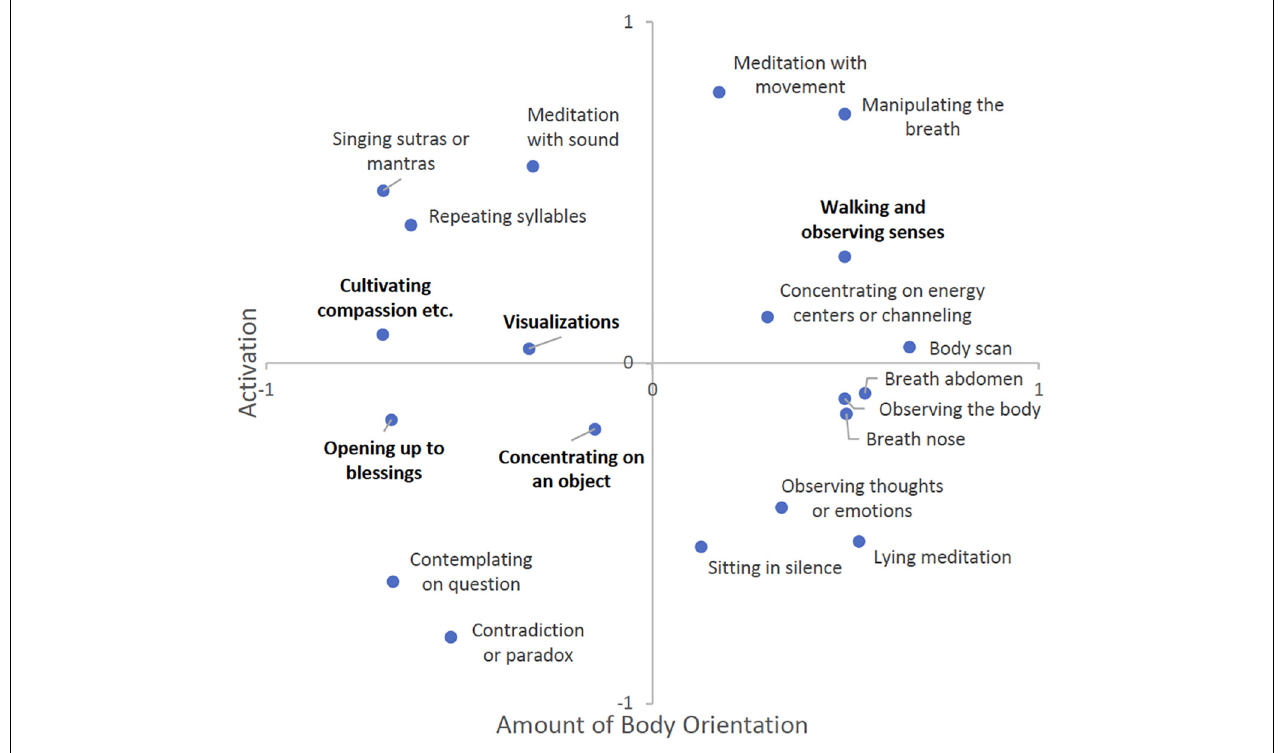
FIGURE 3 | Multidimensional scaling (MDS) solution for Buddhist meditators ( n =